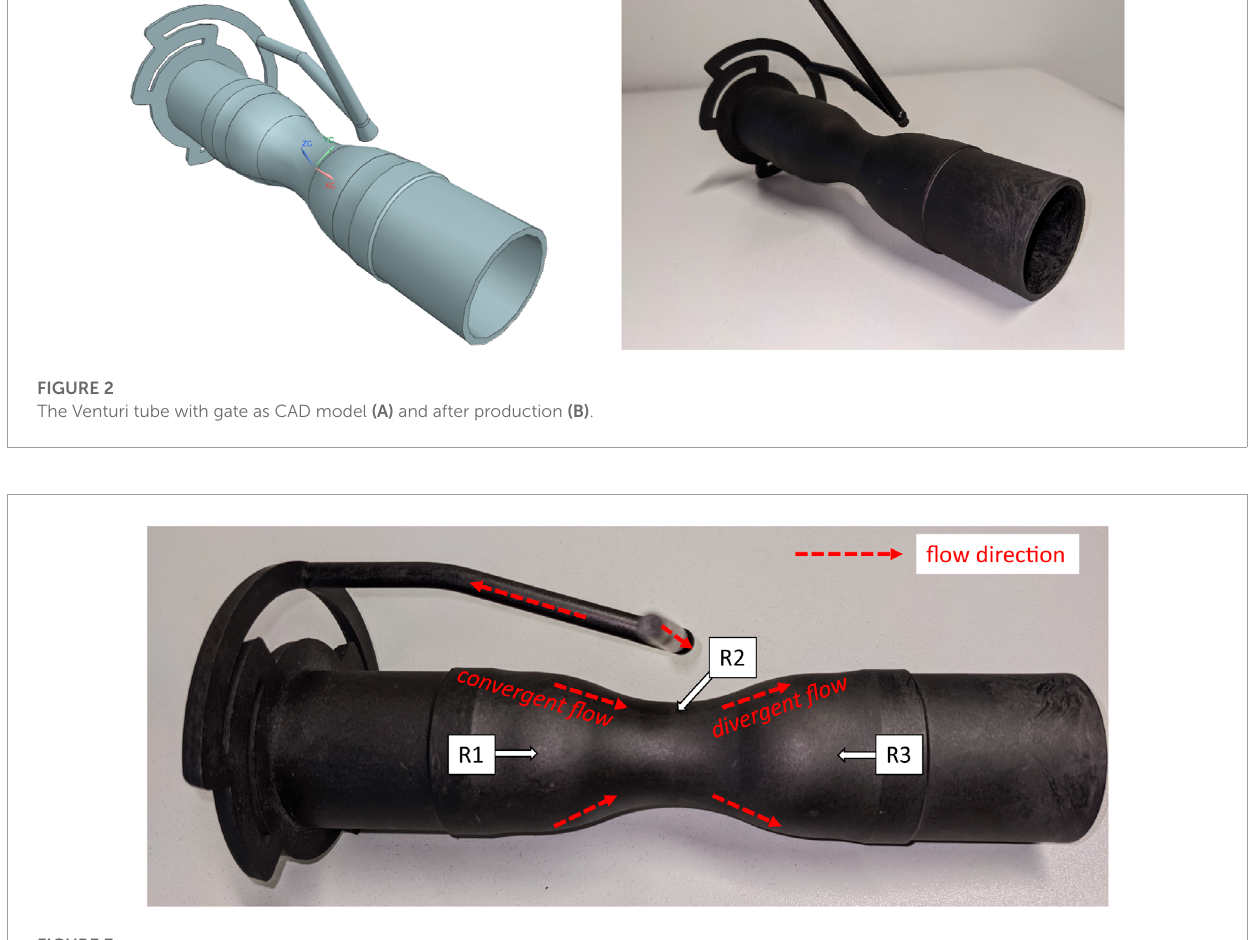
FIGURE 3 Flow directions and location of regions of interest (RoI) for fiber orientation